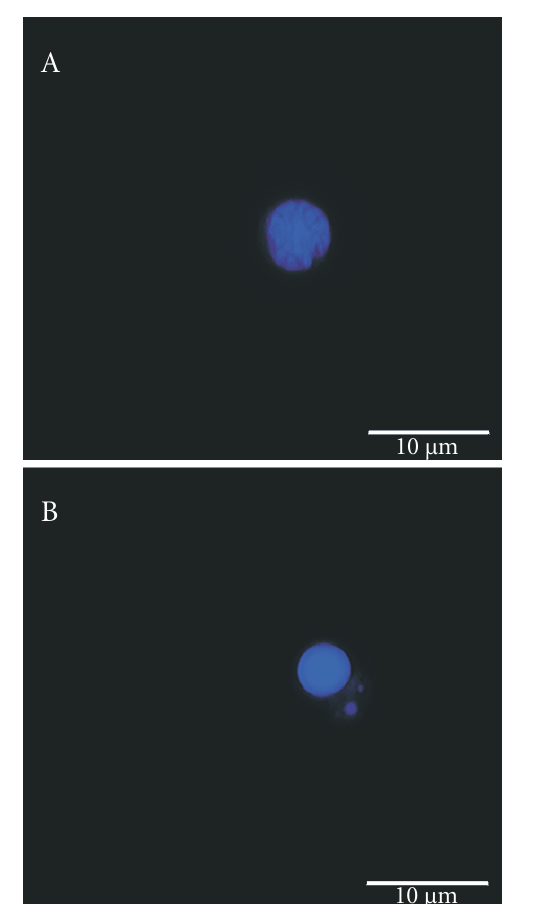
Figure 3: Fluorescent staining of (A) untreated rat peripheral blood lymphocyte and (B) rat peripheral blood lymphocyte exposed to 30 µ M CI-994 for 24hours. Mitogen (concanavalin A, 0.63 µ g/ml) was added to all lymphocyte cultures at time zero. Morphological changes typical of apoptosis including condensed chromatin, apop- totic body,and membrane blebbing are apparent in treated lympho- cyte.